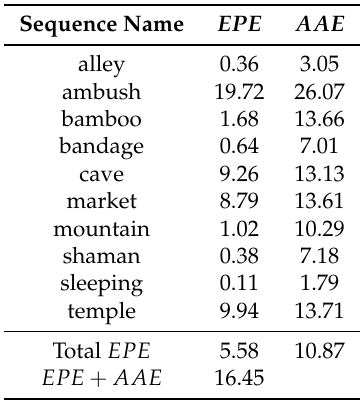
Table 11. Summary of results. The end point error and average angular error obtained by uniform locations in the MPI-Sintel training set.